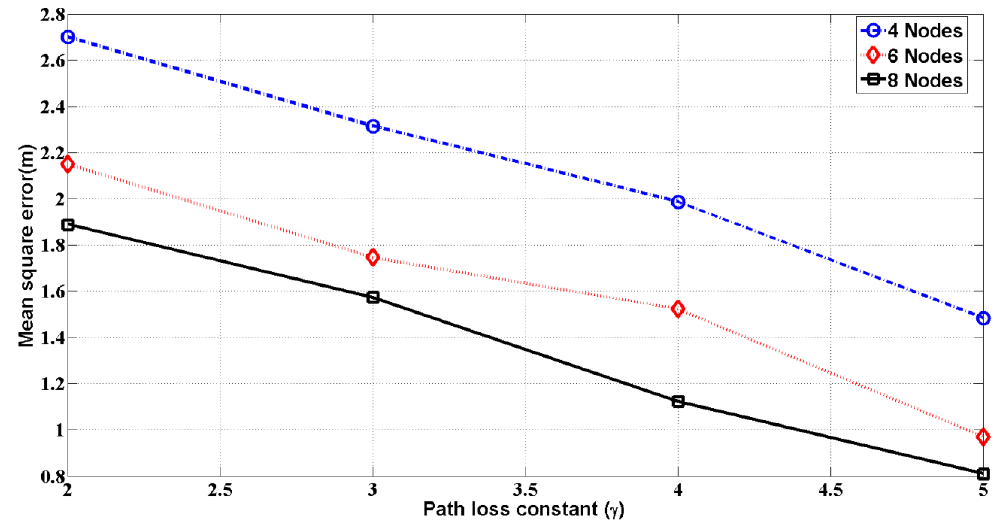
Figure 7. Path loss vs. mean square error